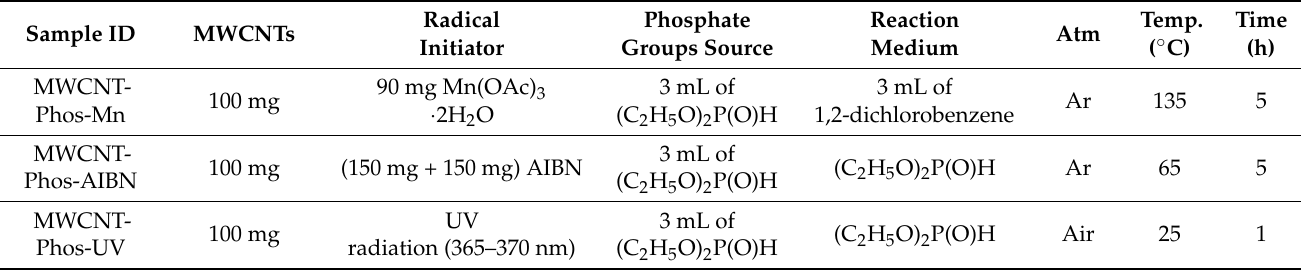
Table 1. Detailed conditions of the functionalization